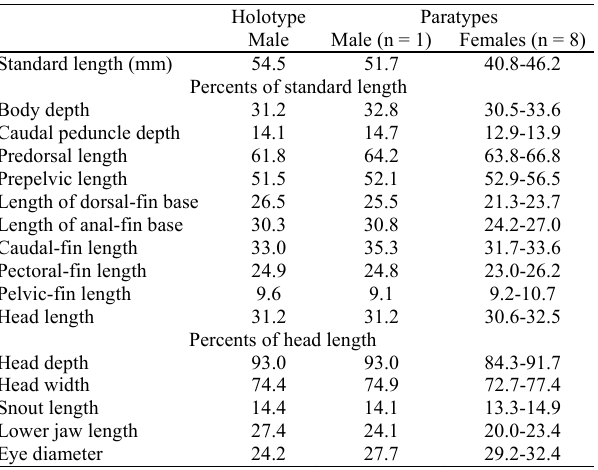
Table 1. Morphometric data of Cynolebias parnaibensis